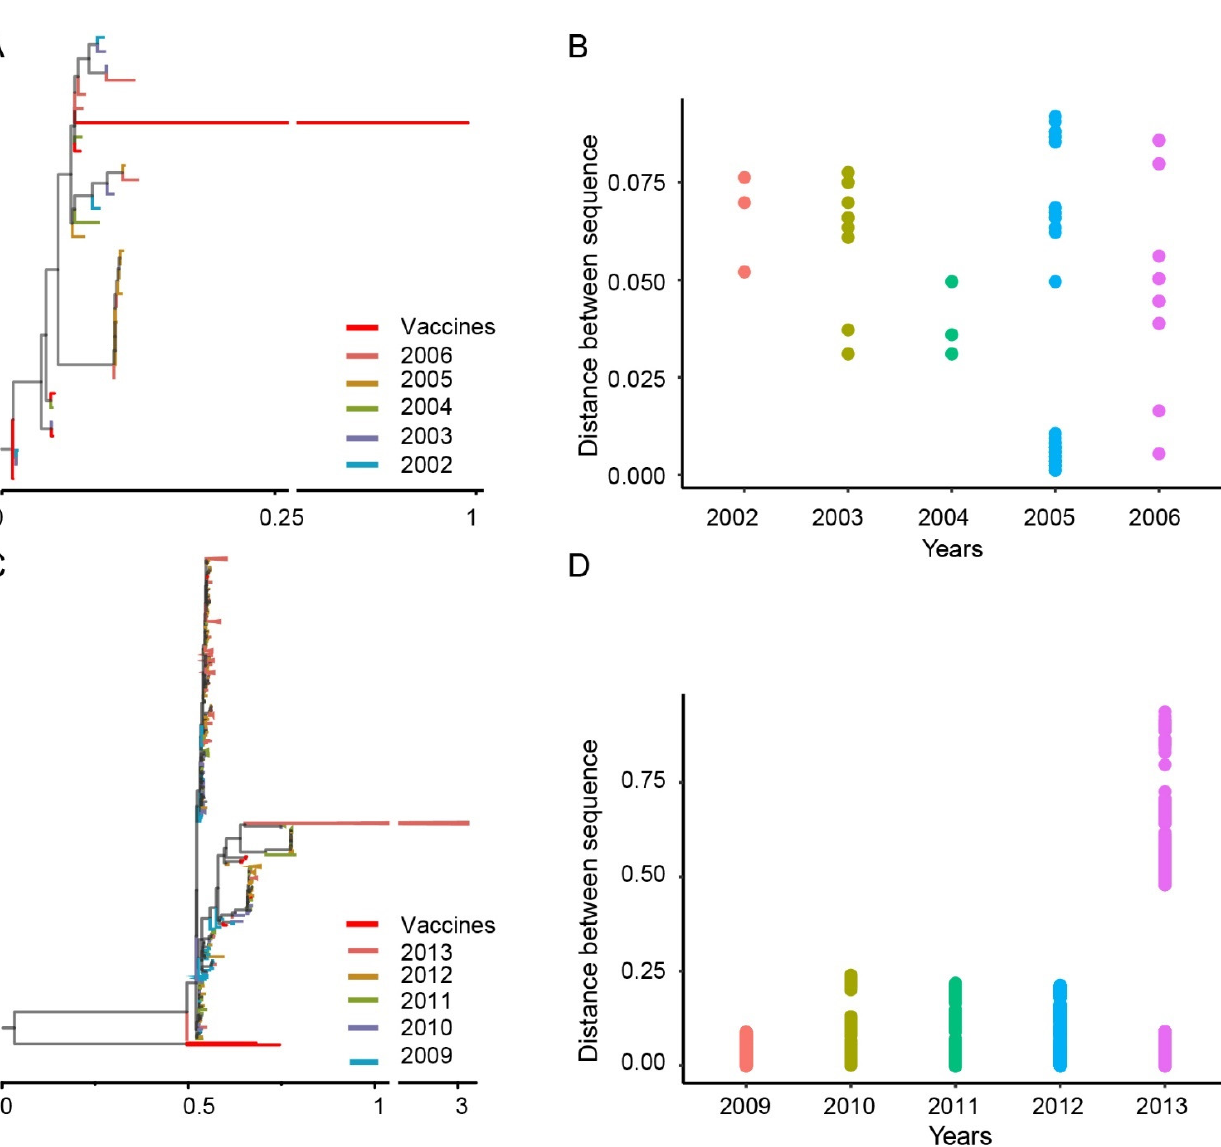
Figure 4. Genetic distance of the HA sequence of the H9N2 subtype avian influenza virus (AIV). ( A ) Phylogenetic tree of the HA gene of H9N2 AIVs. The color of the branch represents the collection date of the sequence, and the vaccine sequence is shown in red. ( B ) Distribution of genetic distances between HA sequences collected annually (excluding vaccine sequences). Genetic distances for different years are indicated in different colors. ( C ) Phylogenetic tree of the HA gene of the H9N2 AIV. The color of the branch represents the collection date of the sequence, and the vaccine sequence is shown in red. ( D ) Distribution of genetic distances between HA sequences collected annually (excluding vaccine sequences).